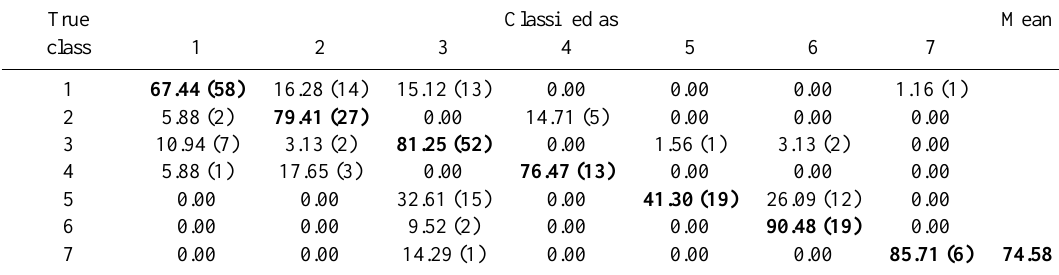
Table 5. Confusion matrix of the random sample TEST (275 images) in % and absolute. True